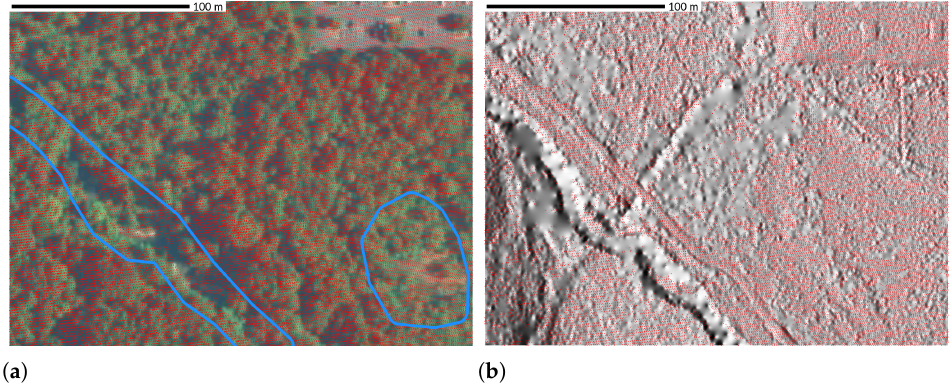
Figure 15. Lower density of ground points in vegetated areas or lack of points in wet areas usually causes these areas to be smoother than the rest of the area when points are interpolated into a DEM: ( a ) Lower density of all return points around a stream and in a vegetated, supposedly wet area (marked in blue). ( b ) Classified ground points (red) missing in some areas completely. The influence on the DEM becomes most apparent when the DEM is used to derive additional products such as the shaded relief here. Dataset: NC Floodplain Mapping Program 2015